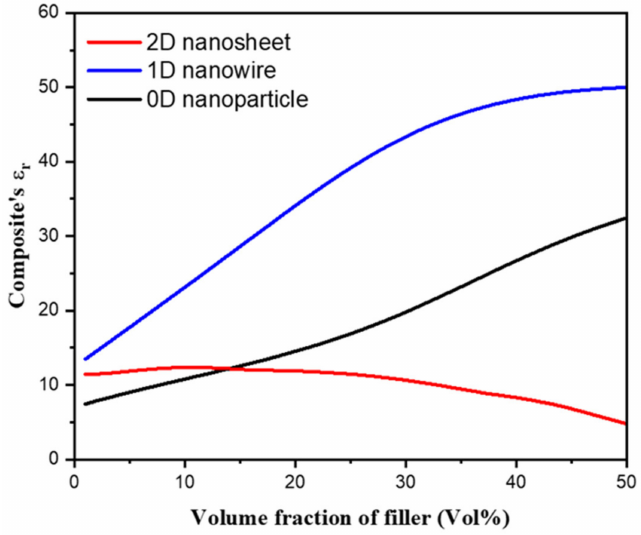
Figure 8. Predicted dielectric constant depends on different filler’s dimensions as a function of filler volume